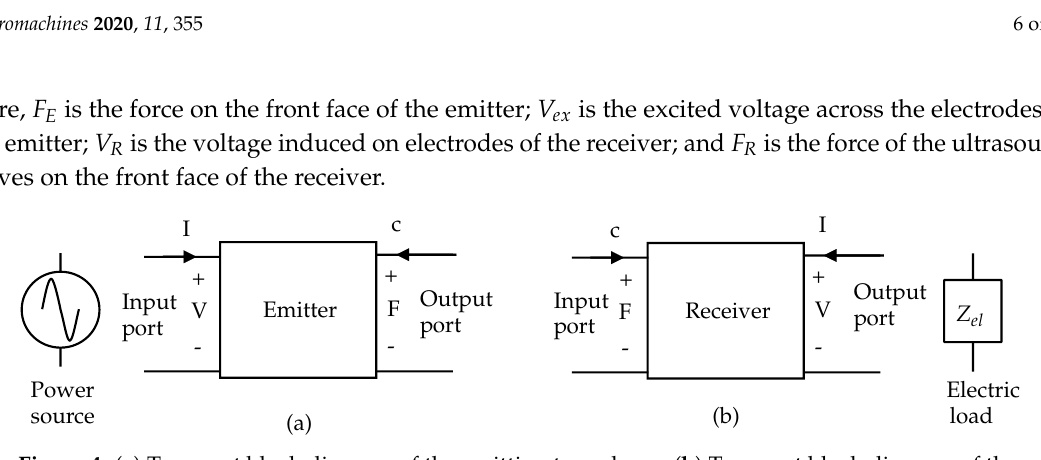
Figure 4. ( a ) Two-port block diagram of the emitting transducer. ( b ) Two-port block diagram of the receiving transducer.